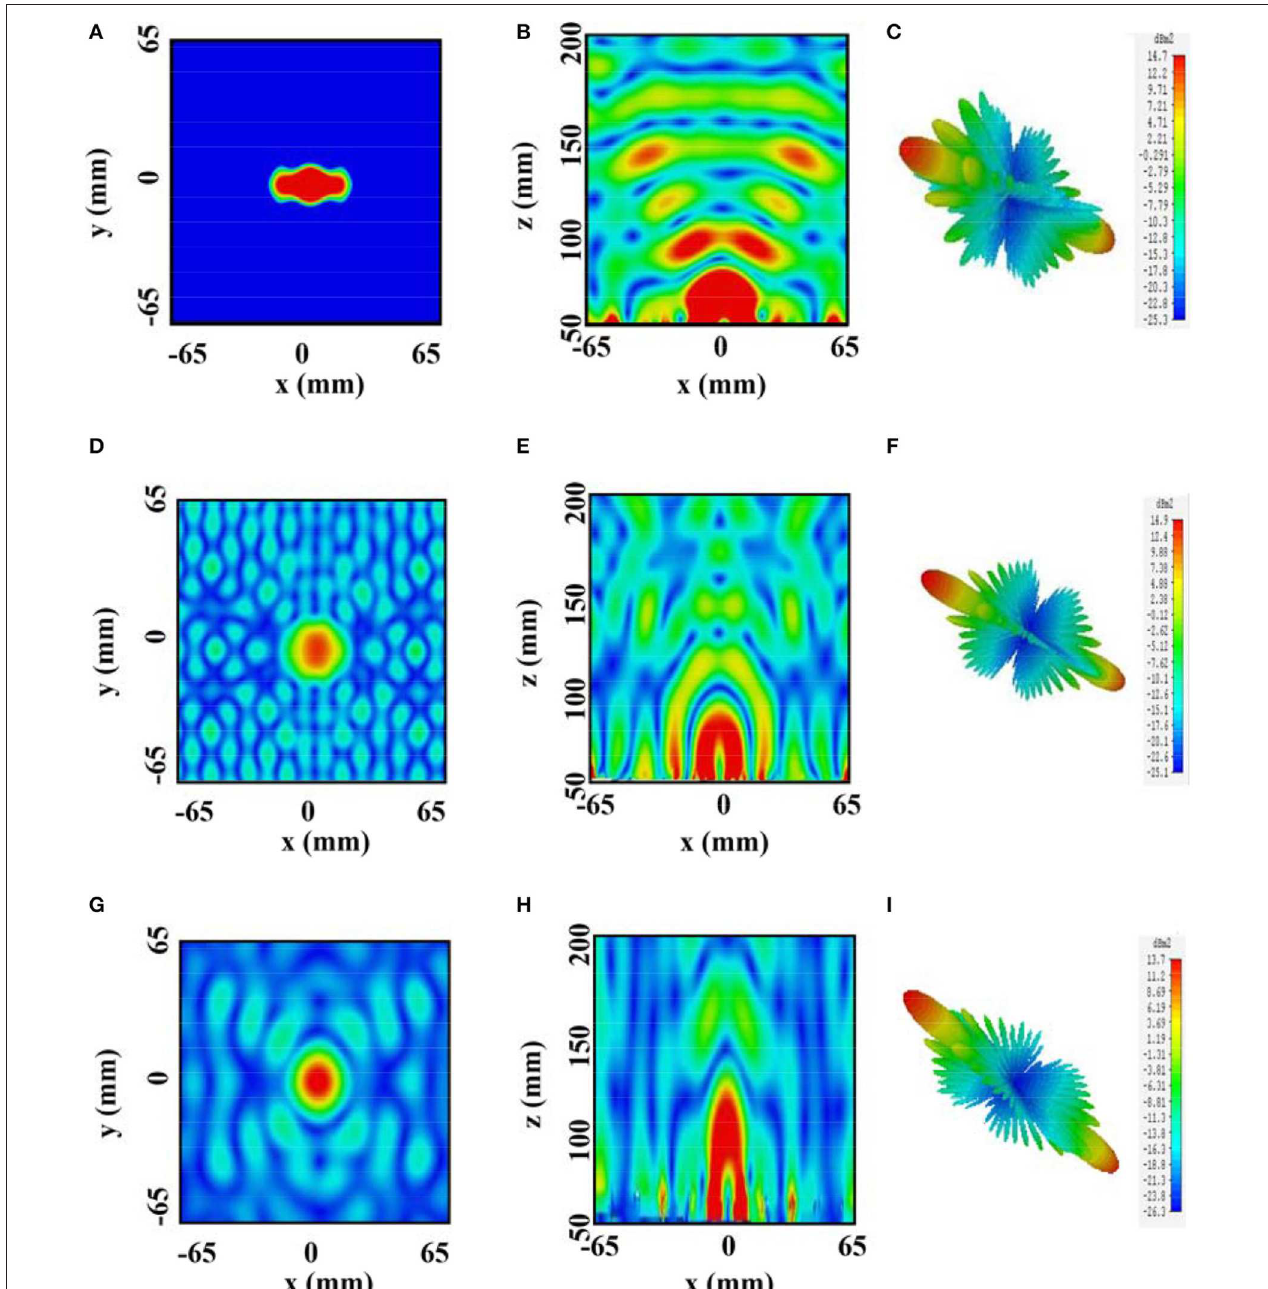
FIGURE 5 | The field intensity, distribution in the y – z plane, x – y plane, and 3D radiation pattern at 20 GHz (A–C) , 19 GHz (D–F) , and 18 GHz (G–I) , respectively.